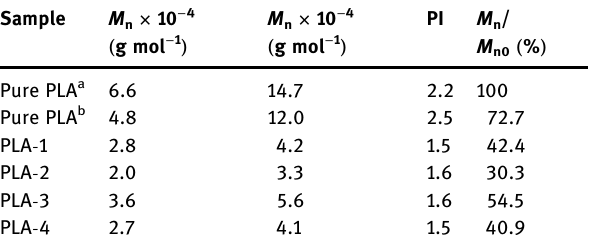
Table 4: Changes in the molecular weight and distribution of pure PLA and PLA in blends after degradation in natural seawater for 180 days